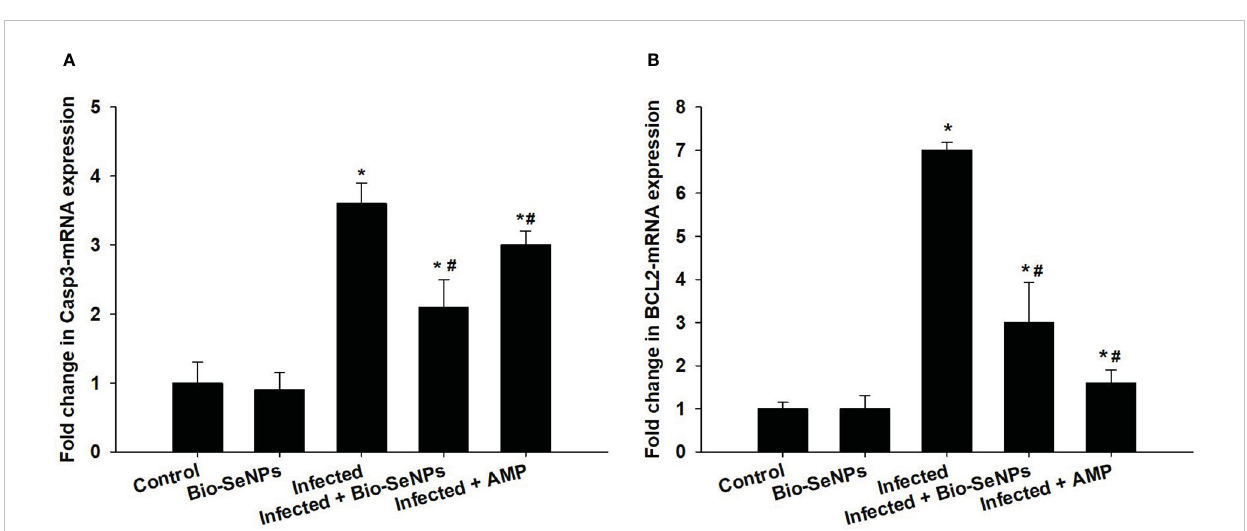
FIGURE 10 Effect of Bio-SeNPs on the mRNA expression of Caspase-3 (A) and BCL2 (B) in the jejunal samples from E. papillata -infected mice. The expression values obtained by RT-PCR analysis were normalized to the reference gene GAPDH mRNA level and are shown as fold induction (in log 2 scale) relative to the mRNA level in the control. * signi fi cance changes concerning the control group, # signi fi cance changes concerning the infected